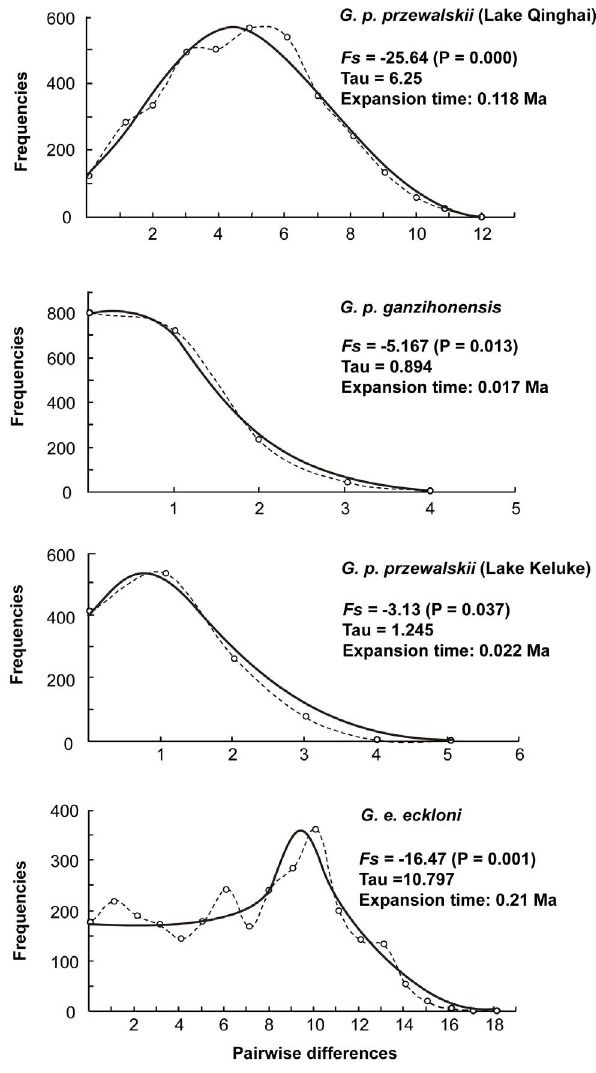
Figure 3. Mismatch distributions of Gymnocypris individuals based on the combined sequence data. The observed frequency is indicated by a dotted line. The expected distribution is represented by a continuous line. The values of Fu’s F s with P -values, t and the expansion time are shown.